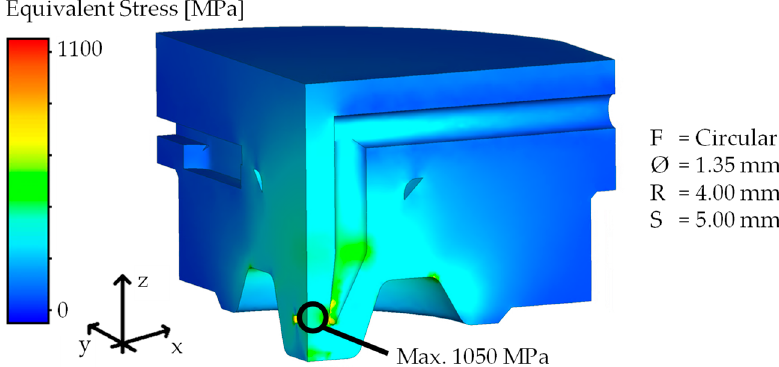
Figure 12. The equivalent stress at 97.5% stroke from Variant 13 (F = circular; Ø = 1.35 mm; S = 5.00 mm; R = 4.00 mm) based on the Minitab calculations.